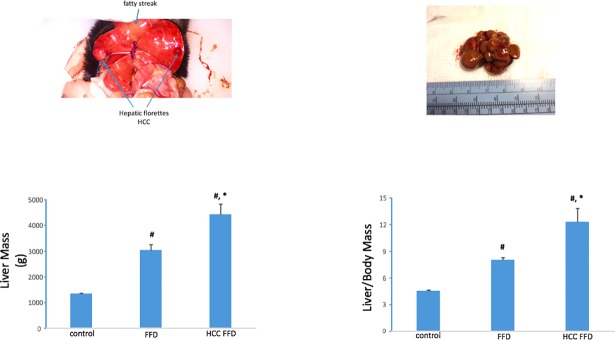
FFD-induced HCC.Of the 76 animals entered into the training set, 65 animals bore no tumors on the liver. Of the 24 animals on FFD for 14 mo, 11 exhibited liver tumors which manifested as one or more polyp-like structures on the liver. Animals on FFD for 14 mo had larger liver and liver to body mass ratios compared to the control diet cohort. Animals with liver tumors (labeled HCC FFD) had the highest values for these endpoints (#, p < 0.01 vs. control; *, p < 0.01 vs. FFD).